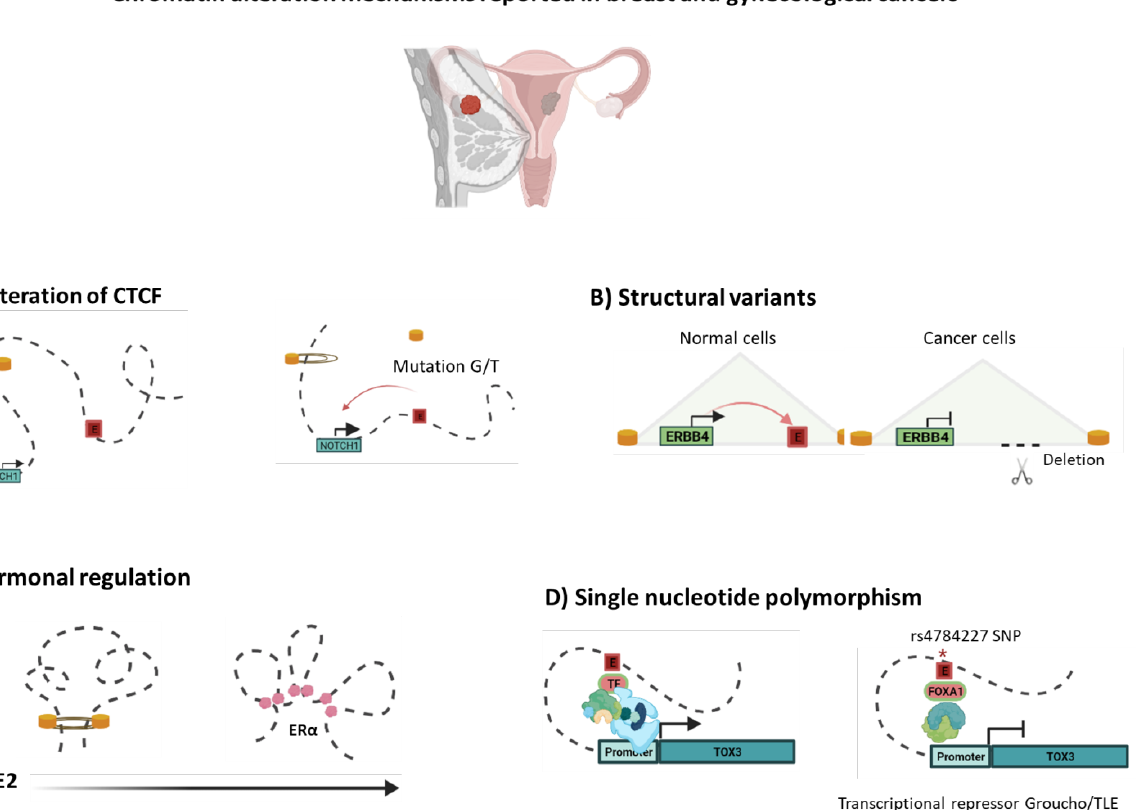
Figure 3. Chromatin alteration mechanisms reported in breast and gynecological cancers. As proper chromatin structure folding is essential for gene regulation, disruption of the TAD structure or inter-TAD modifications may lead to rewiring of chromatin connections to activate certain oncogenes or down-regulation of tumor suppressors. Breast and gynecological cancer genomes have been reported as having diverse alterations, including: ( A ) Mutations in the CTCF motifs anchors (G/T) at the boundary of the TAD motifs, leading to NOTCH1 overexpression. ( B ) Alternatively, structural variants, such as deletions, in cancer genomes can frequently delete enhancers, contributing to oncogenesis by decreasing tumor suppressor gene expression (e.g., ERBB4) [53,54]. ( C ) Another mechanism that has been linked to dynamic changes in chromatin structure is hormonal response. Constant E2 stimulation promotes 3D genome re-compartmentalization by ERa binding, generating chromatin interactions of invasion-related oncogenes [59]. ( D ) Single nucleotide polymorphisms (SNPs) often exist in CREs, which may cause changes in interactions. The rs4784227 SNP alters the sequence of recognition of an enhancer that controls TOX3 gene transcription, favoring the binding of the FOXA1 transcription factor and Groucho/TLE, resulting in decreased expression of the TOX3 tumor suppressor gene